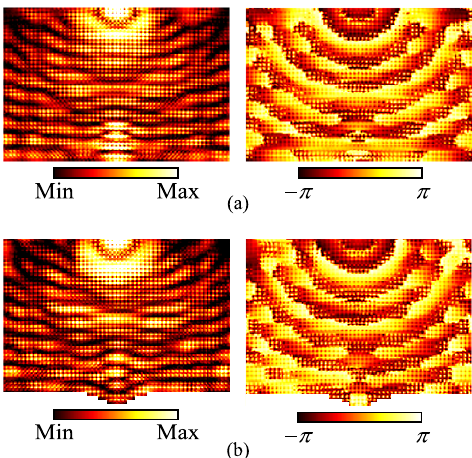
Fig. 22. Measured complex electric near- fi eld distributions with a point source at the top center (Position A in Fig. 19) at 2.60 GHz. Left: Amplitude. Right: Phase. (a) With the groove illusion medium. (b) With the original groove.